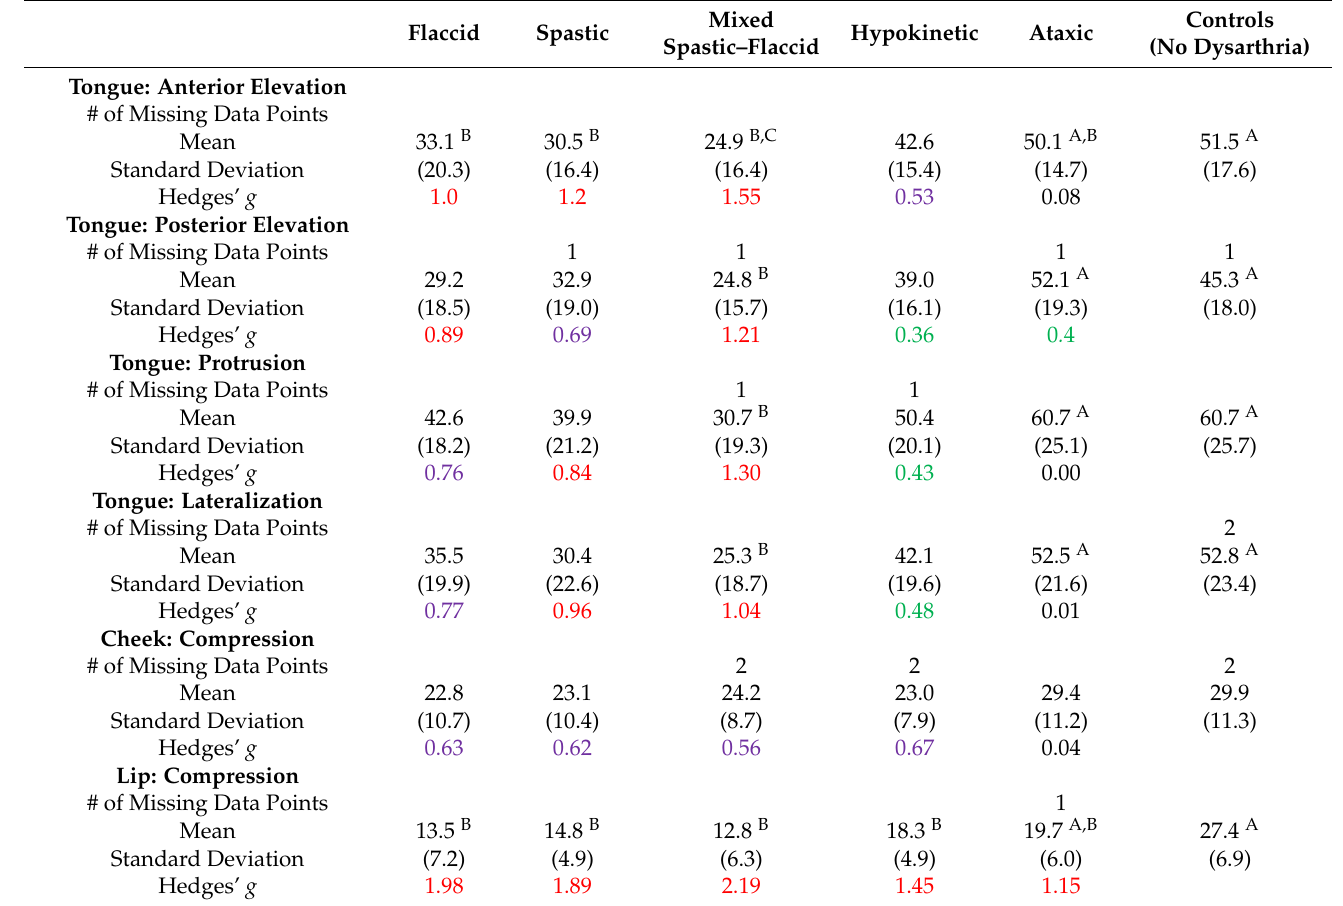
Table 3. Summary Statistics for P max (in kPa) Across Participant Groups for Each